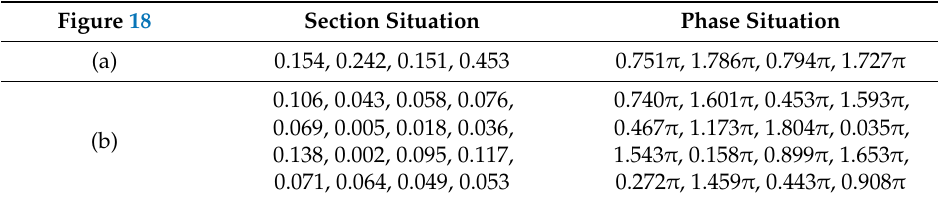
Table 12. Parameter settings of MPSM jamming under optimized sections situation and the phase situation. Figure